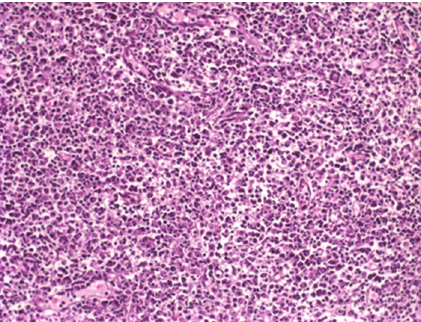
Figure 3: Numerous CD68 histiocytes surrounding the areas consist of karyorrhectic debris (H&E, ×